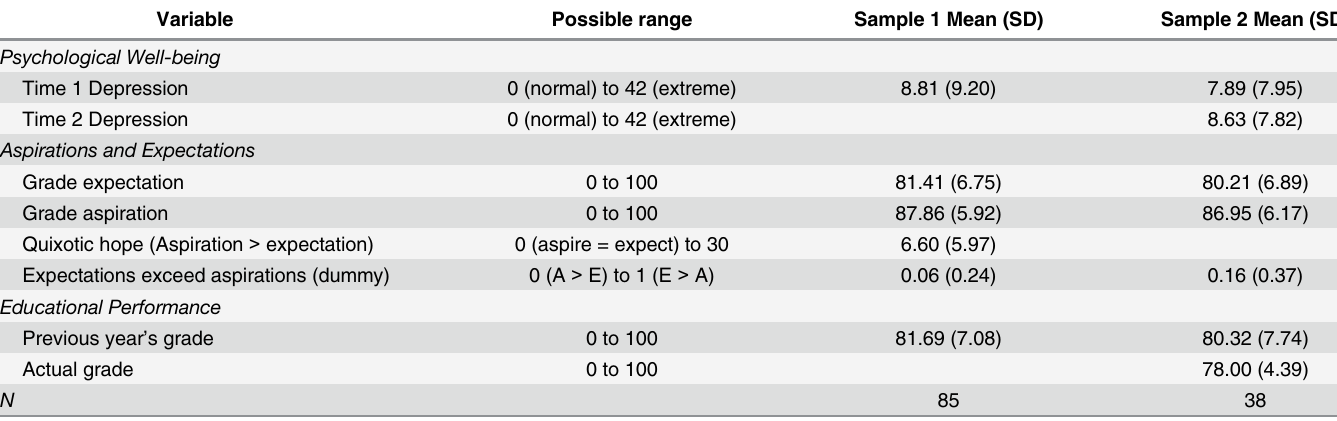
Table 1. Means and standard deviations for measures included in the model (Study